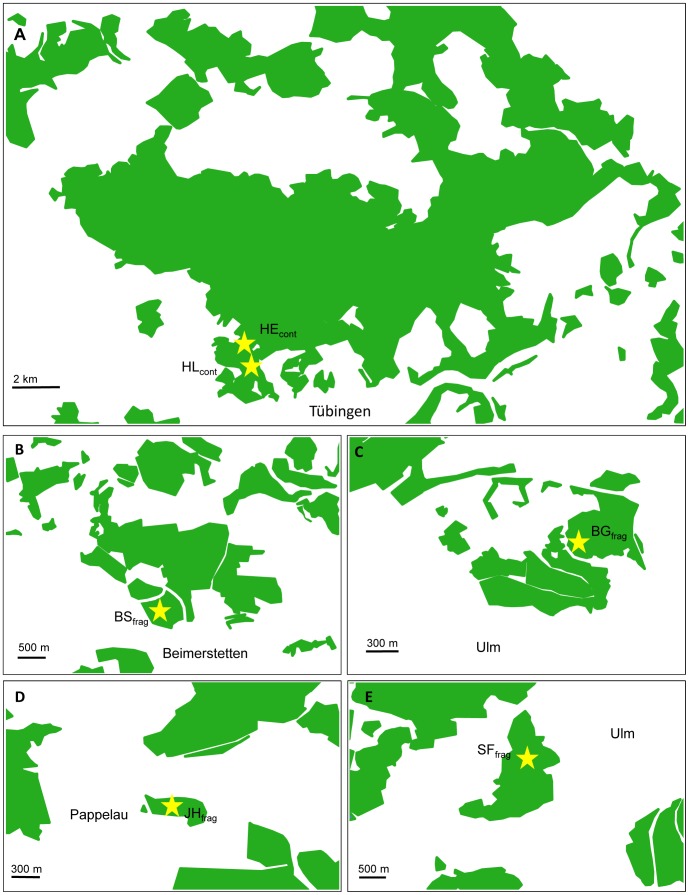
Maps showing: A) study sites HEcont and HLcont within the continuous forest close to the town Tübingen; B–E) study sites within the forest fragments close to the town Ulm (B: BSfrag; C: BGfrag; D: JHfrag; E: SFfrag).Green areas mark forest cover and asterisks the centre of the respective study sites.